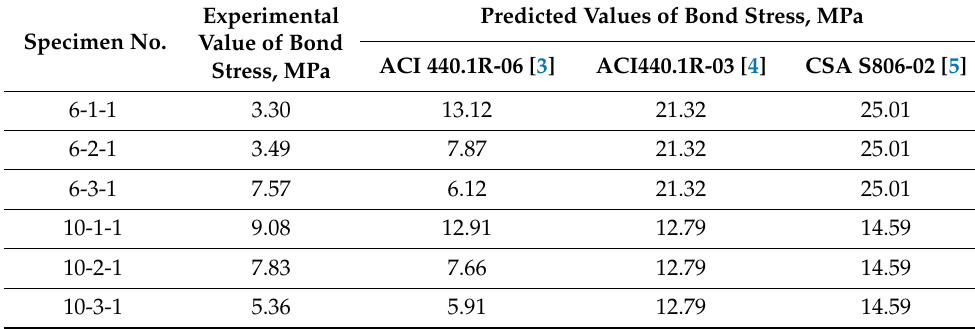
Table 6. Comparison of experimental and predicted values of bond strength.